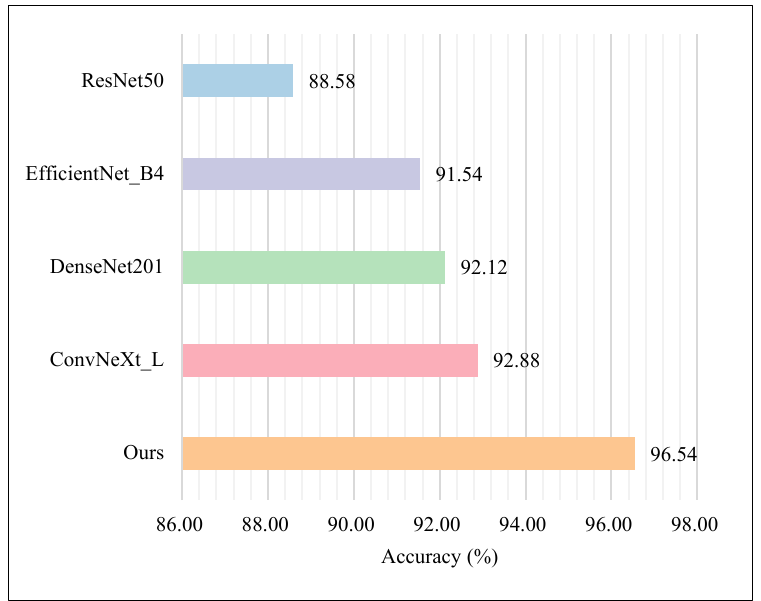
Figure 7. The best test accuracy of each model on our private dataset.